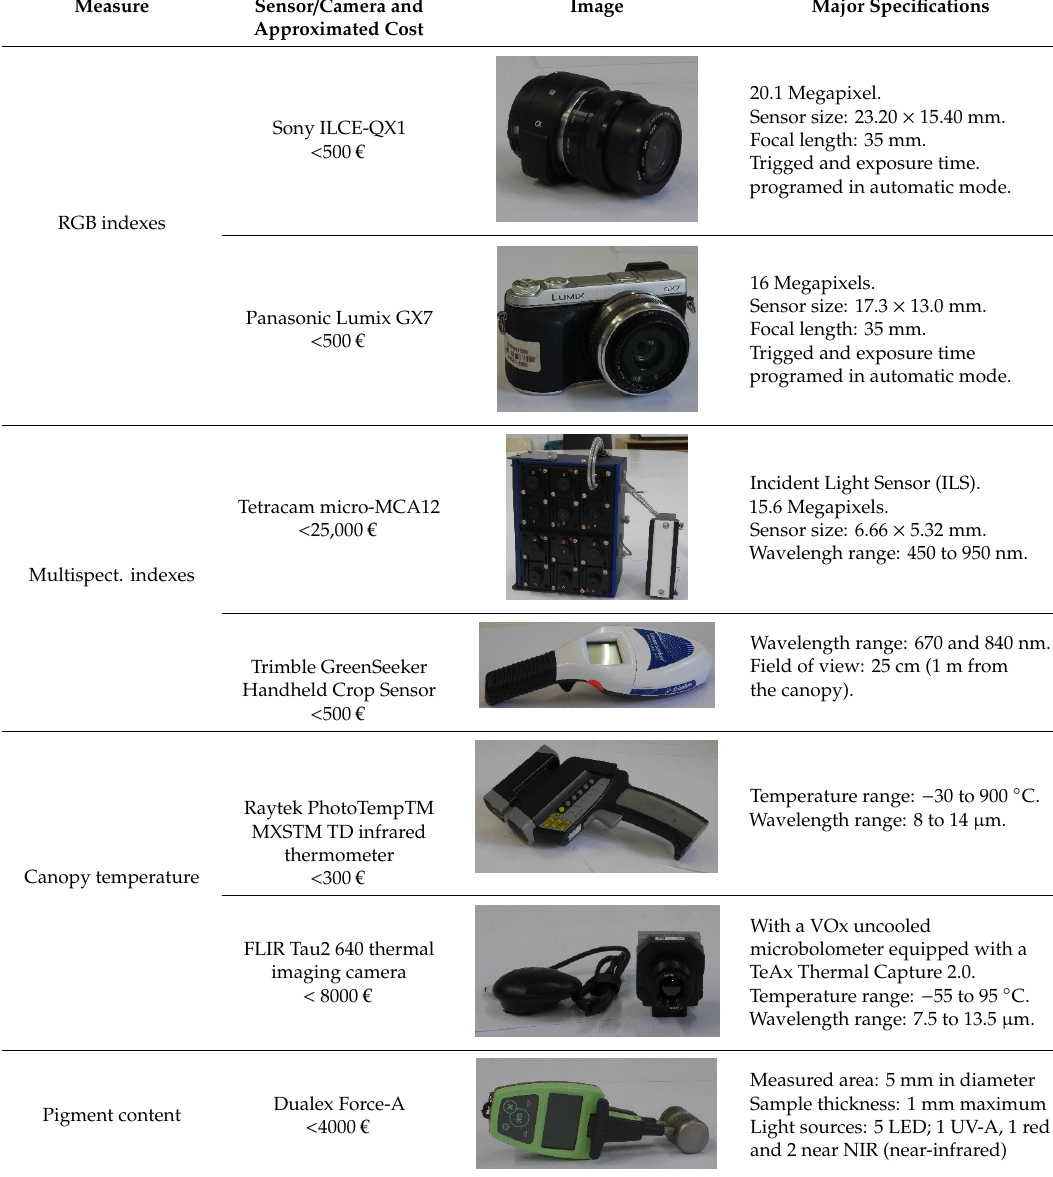
Table 3. Sensors and cameras used during this experiment and their major